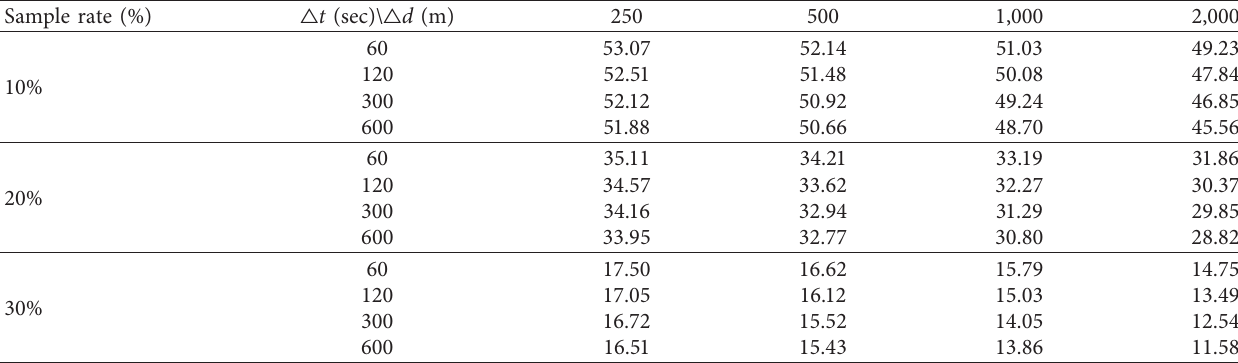
Table 10: MAPE by sample rate, unit section, and unit time of scenario 2 (empirical evaluation). Sample rate